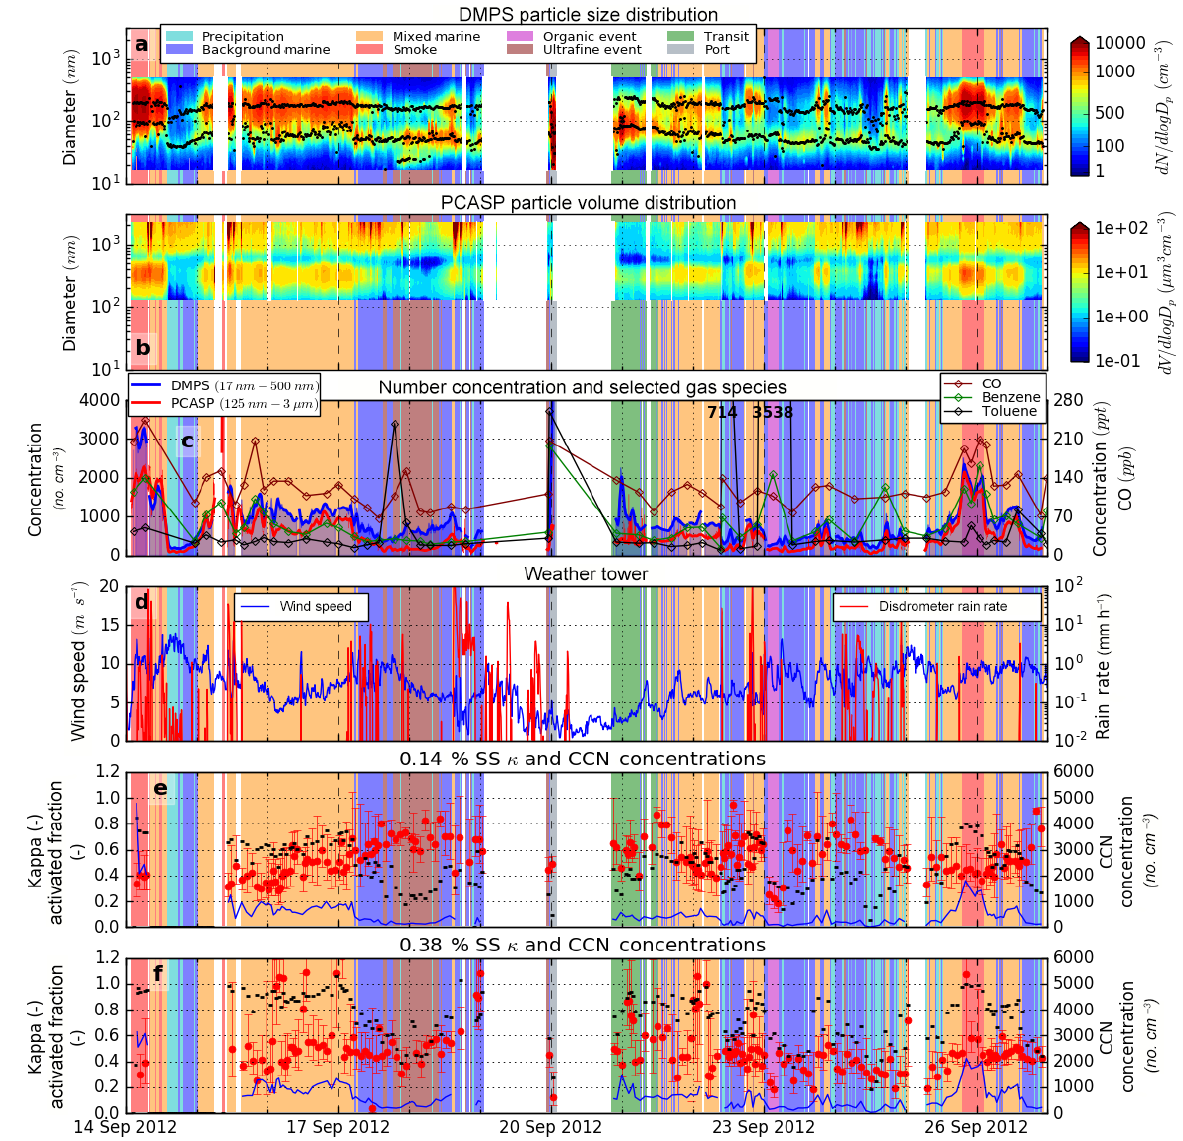
Figure 2. Time lines of measured and derived variables during the Vasco 2012 cruise. In all figures, background colors correspond to aerosol type classification from the cluster analysis, as indicated in the legend in panel (a) . (a) d N/ dlog D p spectra from the CCN system measurements with black dots at best-fit modal median diameters; (b) d V/ dlog D p spectra derived from the PCASP measurements; (c) total number concentrations measured by the CCN system (blue; shaded below for contrast) and the PCASP (red), with 60min boxcar average smoothing; gas canister grab sample concentrations for carbon monoxide, benzene, and toluene are shown on the right axis with colored numbers indicating points above the upper scale extent; (d) wind speed and disdrometer rain rate from the Vasco weather tower. (e, f) κ parameter (red) and CCN concentrations (blue) for 0.14 and 0.38% supersaturation settings (corresponding approximately to accumulation and Aitken modes, respectively), with total activated particle number fraction (CCN SS% / CN Total ) bars in grey. Error bars on κ data points indicate the κ values associated with 25% / 75% activated fraction curve